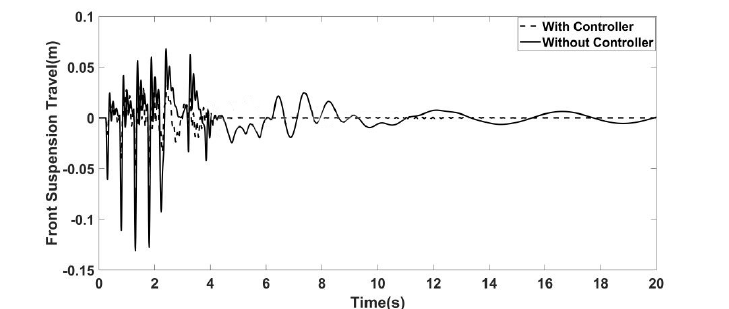
Figure 13. Front Body Displacement.